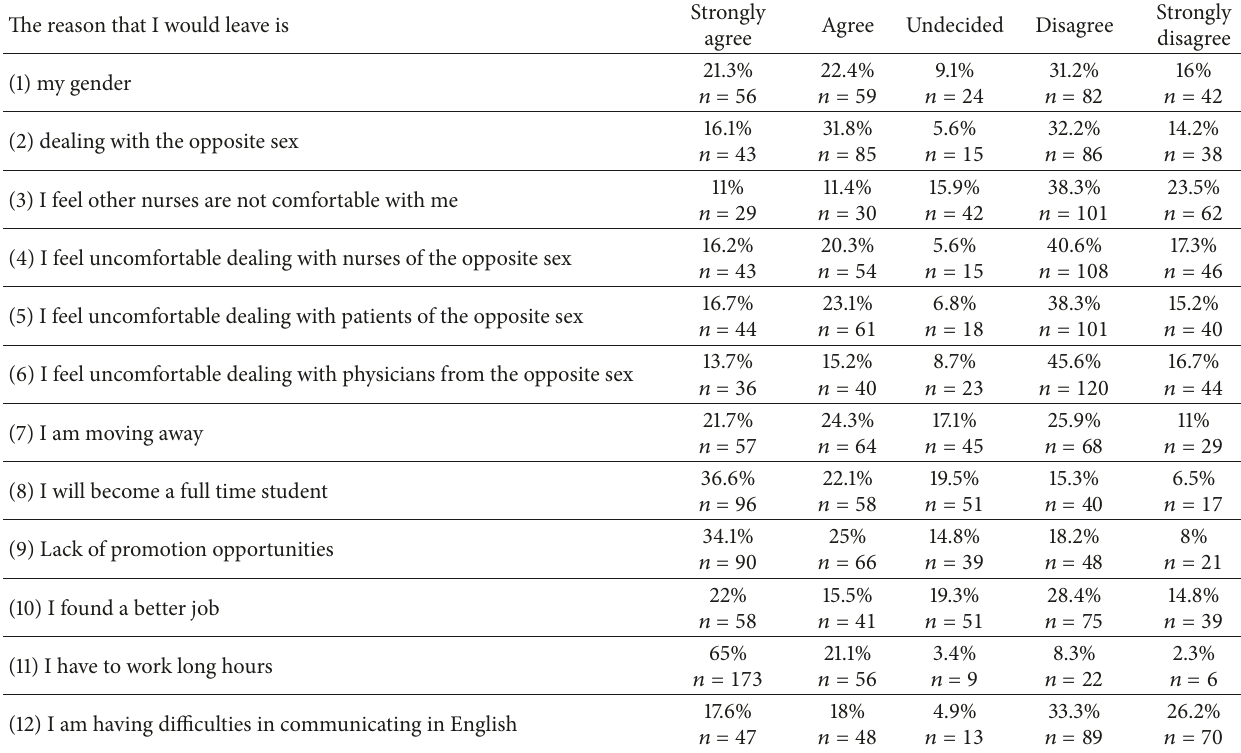
Table 5: Reasons for considering leaving